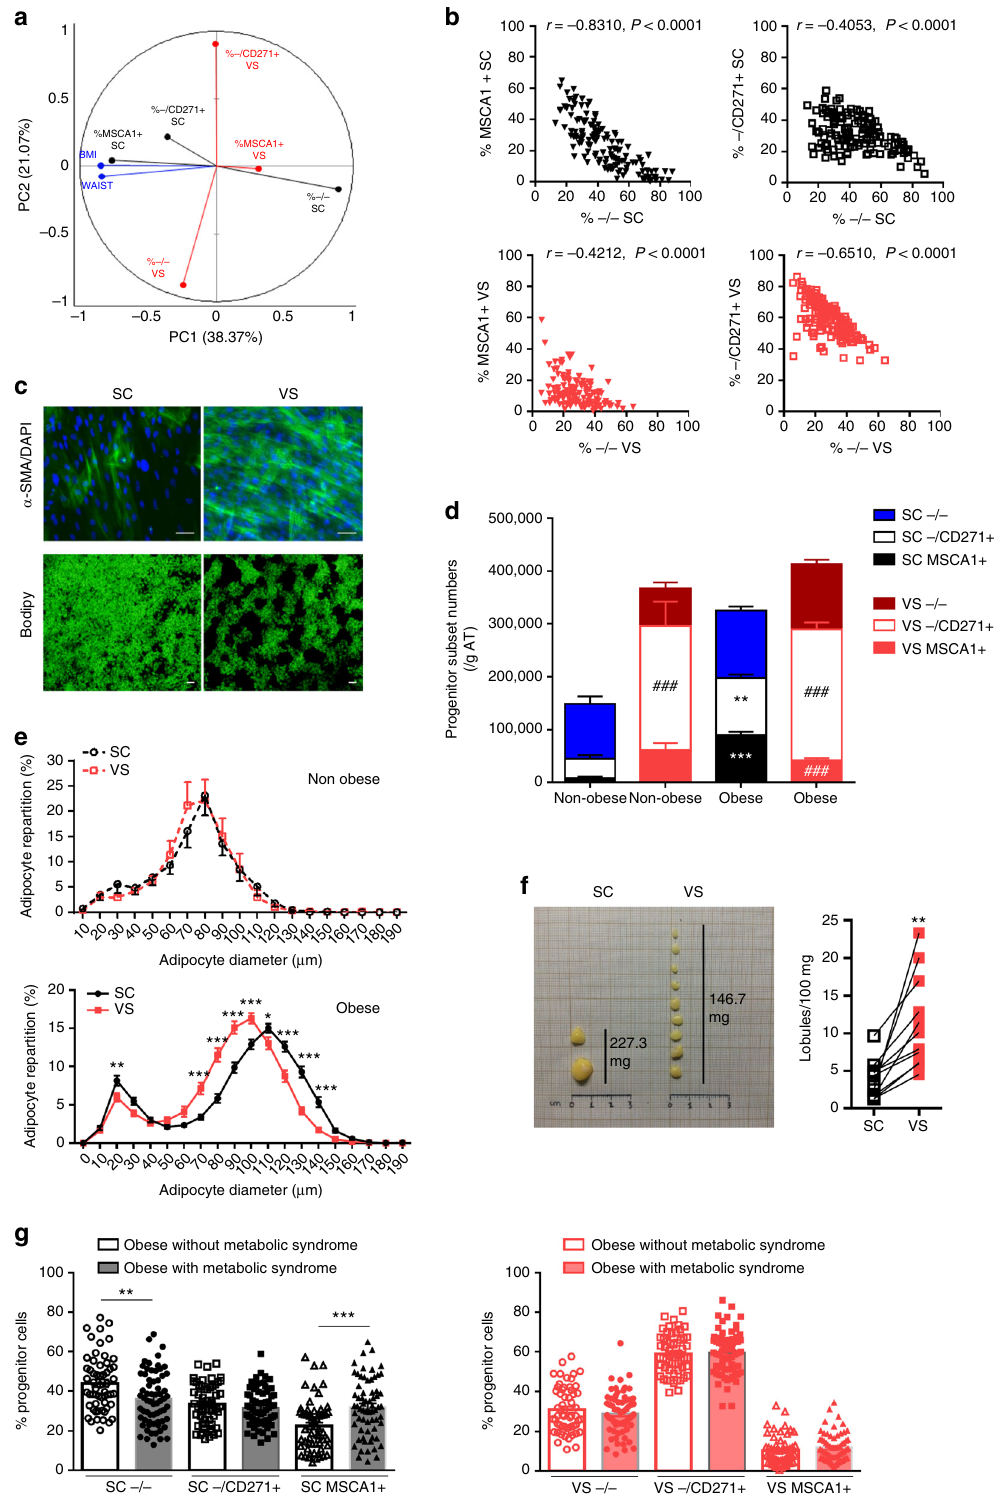
Western blot analysis . Cells were lysed in RIPA buffer supplemented with anti- (2 components, 150 genes per component) using all cellular subsets and similarly protease and anti-phosphatase. In total, 10 – 30μg of protein lysates were resolved selected 400 genes (2 × 200) using the cellular subset as a discrete outcome, using using the following primary antibodies: polyclonal rabbit anti-human CD271 both locations combined as well as independently. Heatmaps were plotted with (Santa Cruz Biotec NGFR p75 (H-92) sc-5634, 1:500), polyclonal rabbit anti- the cim function from mixOmics. Superpathways were analyzed using GeneAna- human GLI1 (ThermoFisher PA5-17303, 1:1000), and monoclonal mouse anti- lytics geneanalytics.genecards.org (Gene Cards Suite) and Gene Ontology pathways human α SMA (DAKO clone1A4, 1:1000). Detection was performed with an using Gene Ontology Resource (Panther analysis, GO Ontology database released appropriate HRP-coupled secondary antibody and West Dura reagent 2019-01-01). NATURE COMMUNICATIONS| (2019) 10:2549